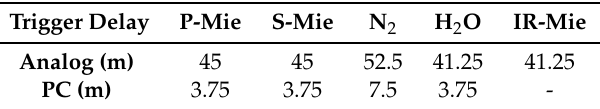
Table 4. The distance corresponding to trigger delay for the analog and Photon Counting (PC) detection chain in each of the detection channels. The spatial resolution of the measurement was limited to 3.75m by the range resolution of the transient